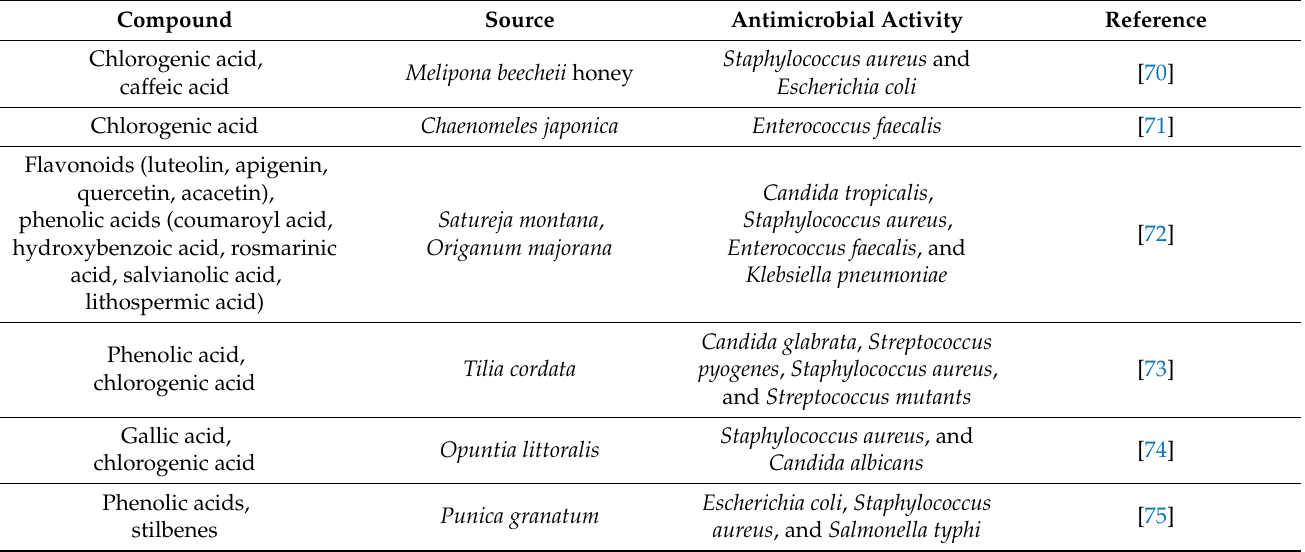
Table 2. Phenolic compounds and their antimicrobial